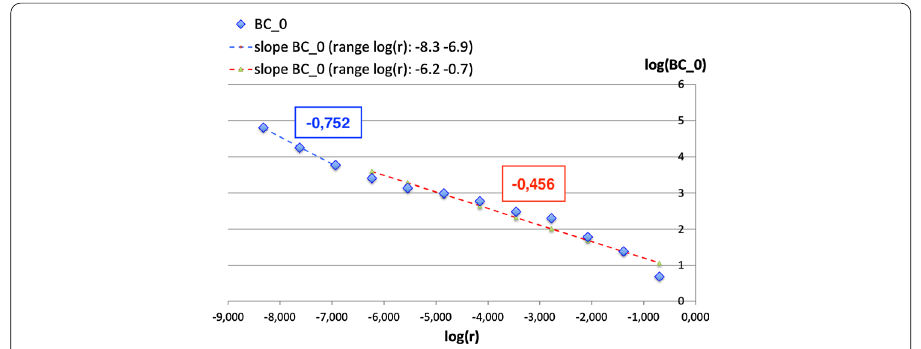
Fig. 5 Example of box-counting plots ( BC 0 r ( D , long ) ) for the context attribute representing the longitude with q = 0 . Notice that, in order to extract the behavior of the dataset on the largest scale range, the computation of the slope takes into account the presence of variations in the sequence of values. At the end, the slope of the straight line with maximum support (the red one in this case) is